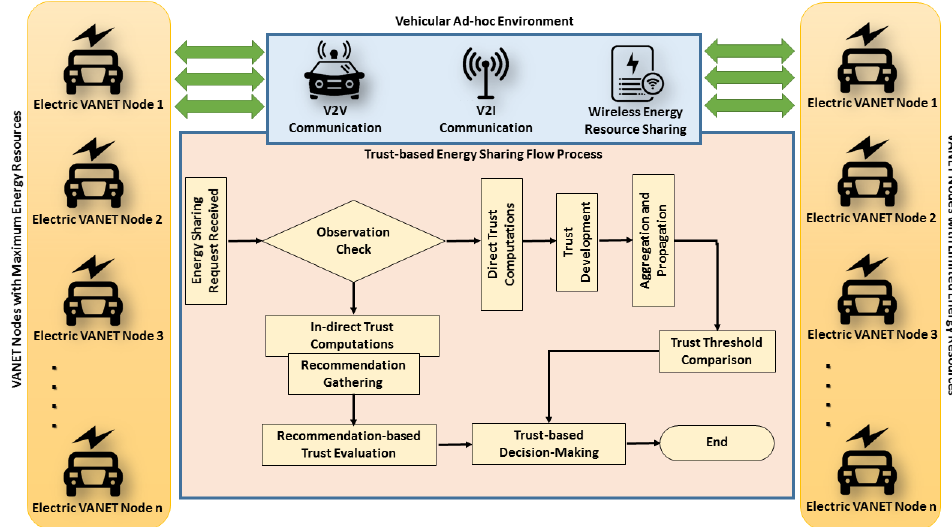
Figure 2. The architecture of the proposed vTrust